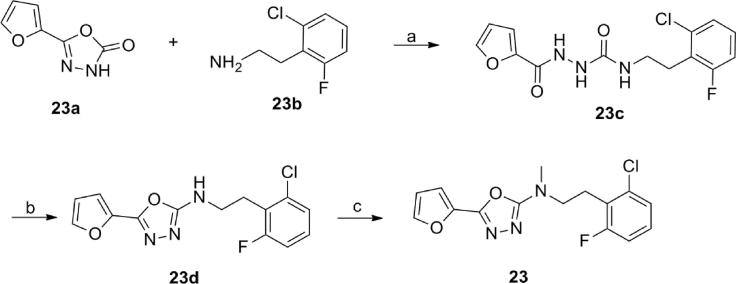
Synthesis of compound 23. Reagents and conditions: (a) EtOH, 100 °C; (b) POCl3, 110 °C; (c) MeI, NaH, DMF.